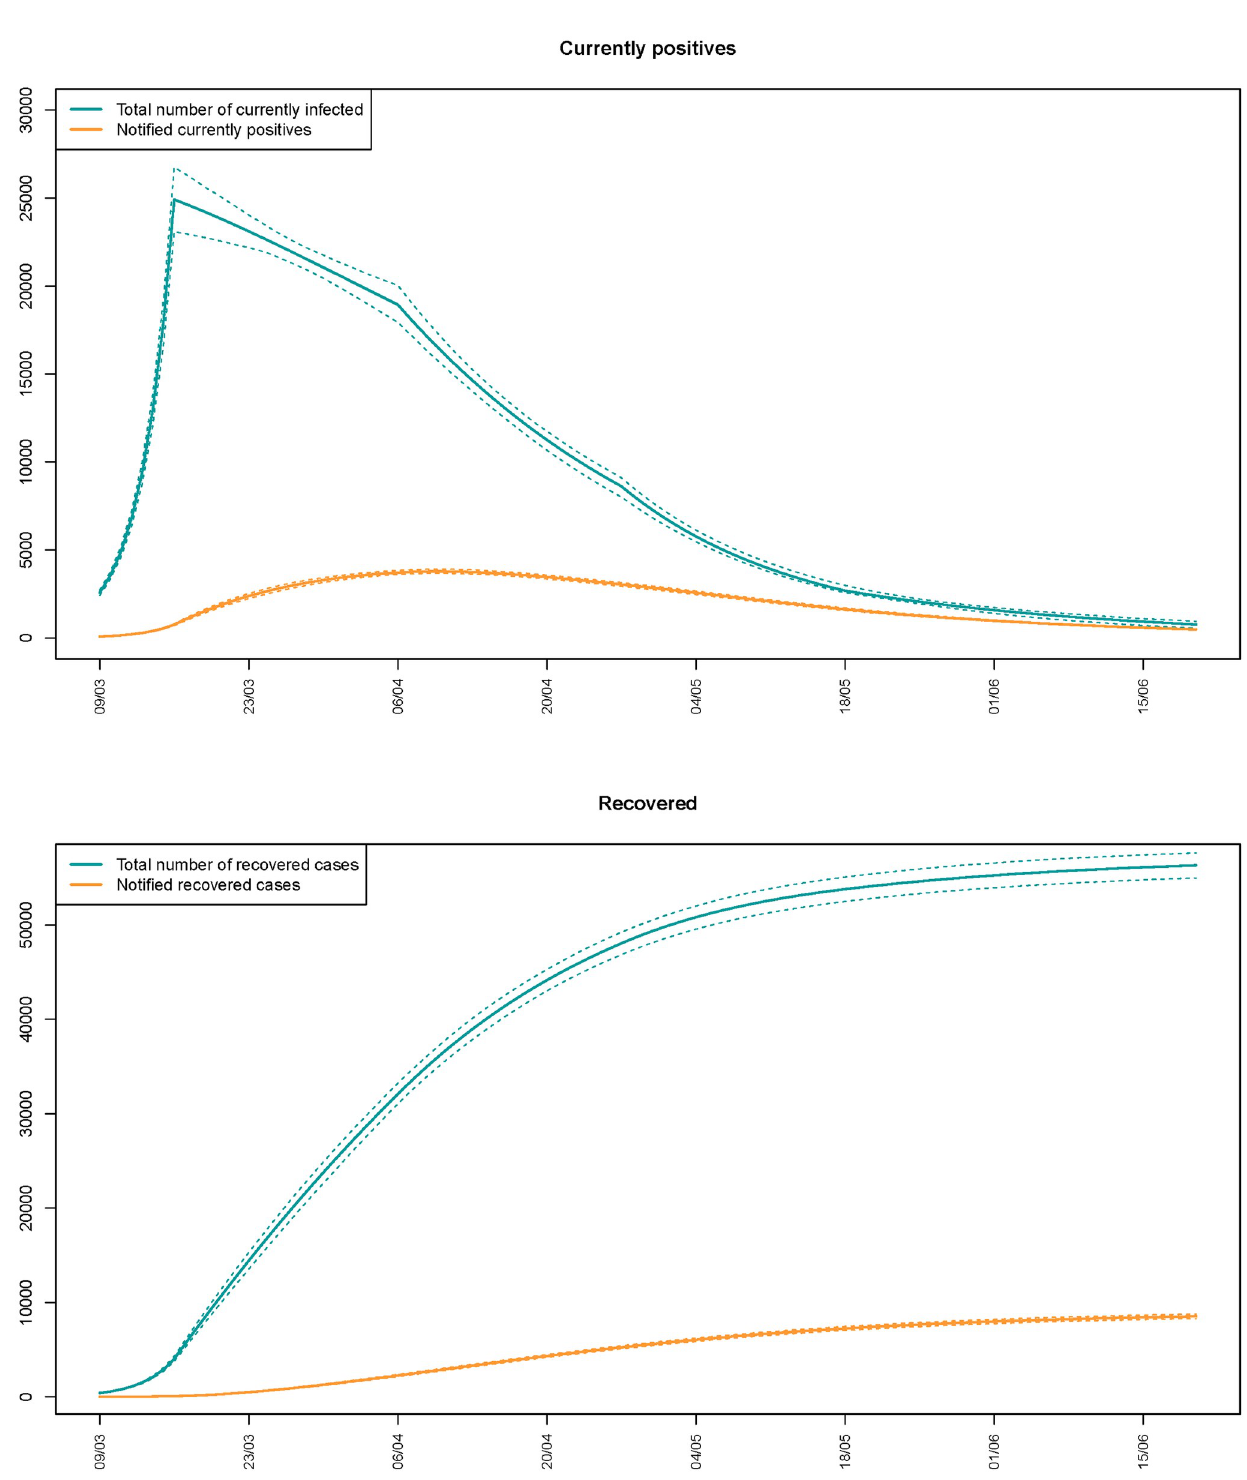
Fig 5. Evolution in time of the total daily number of currently infected and recovered individuals, part of whom are notified (orange line).